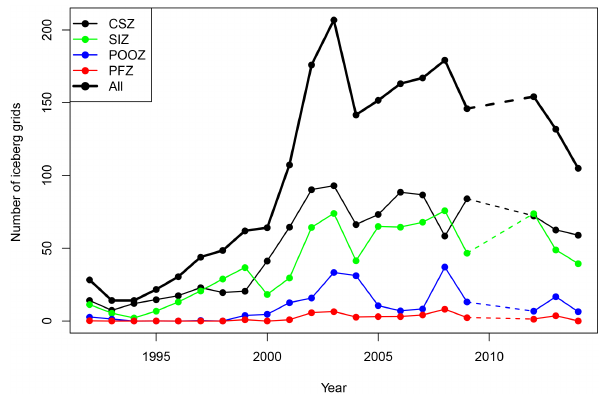
Figure 8. Temporal trend of annual number of grids occupied by large icebergs 1992–2014.